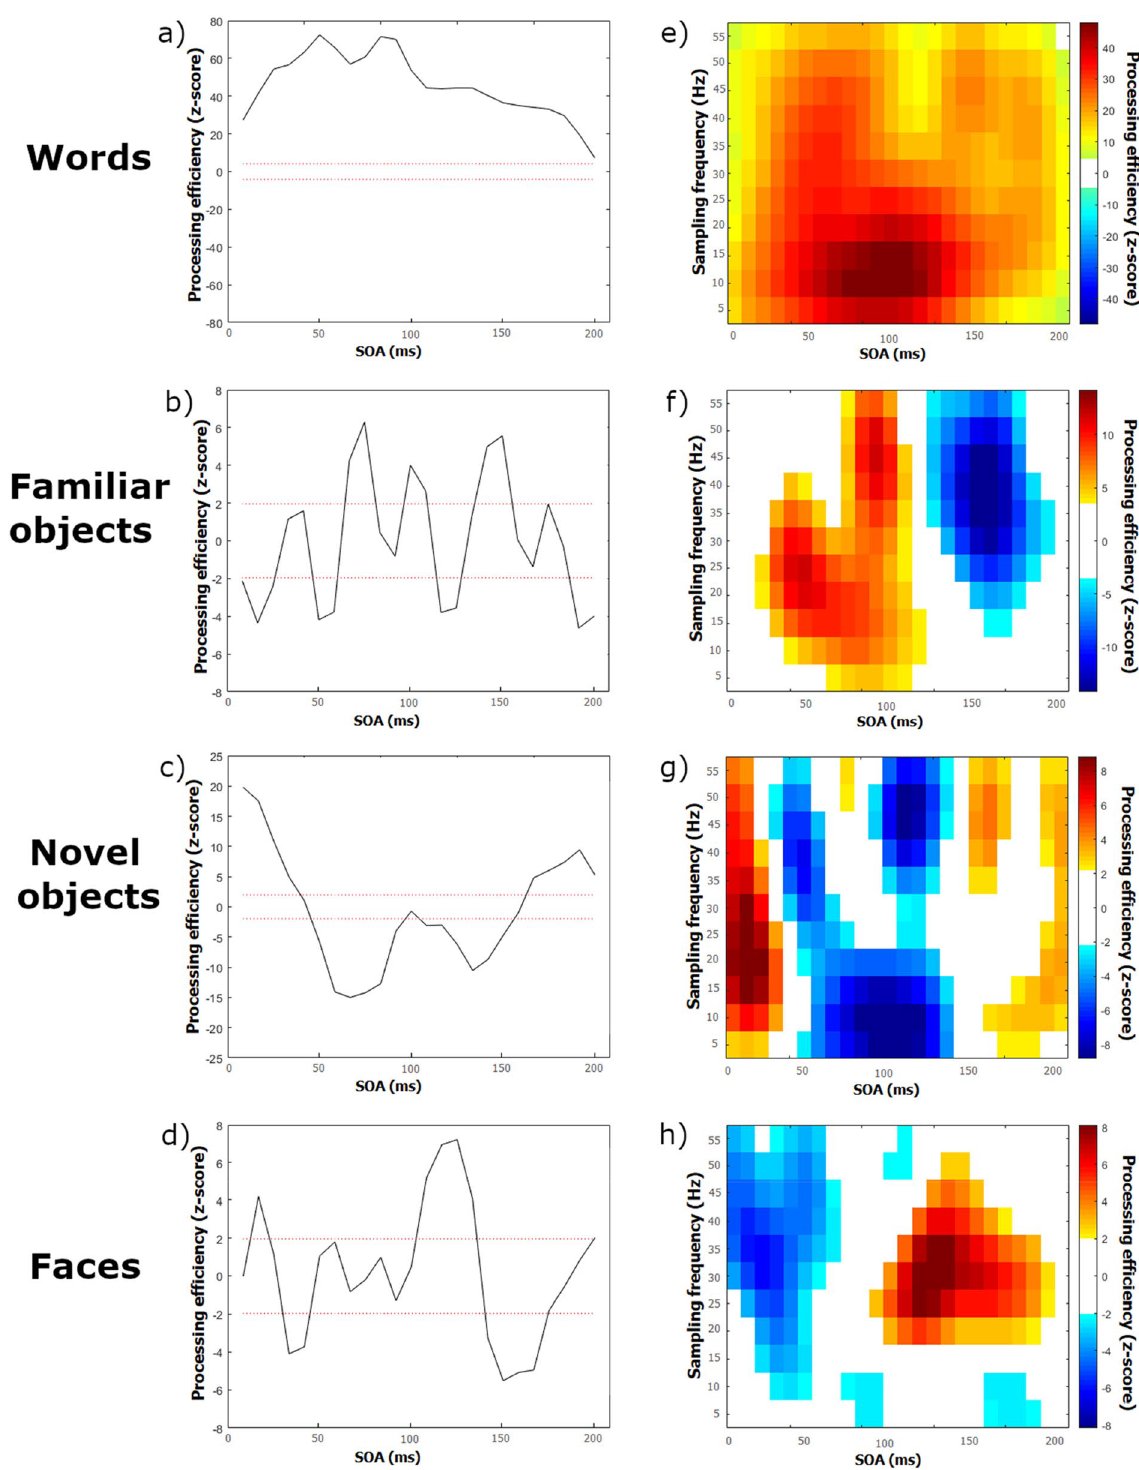
Figure 3. Classification images of encoding effectiveness (in Z scores) as a function of the time elapsed since target onset (stimulus onset asynchrony; SOA—panels a – e ) and as a joint function of the frequency content of stimulus oscillations and SOA (panels e – h ). Stimuli are: words ( a , e ), familiar objects ( b , f ), novel objects ( c , d ), and faces ( d , h